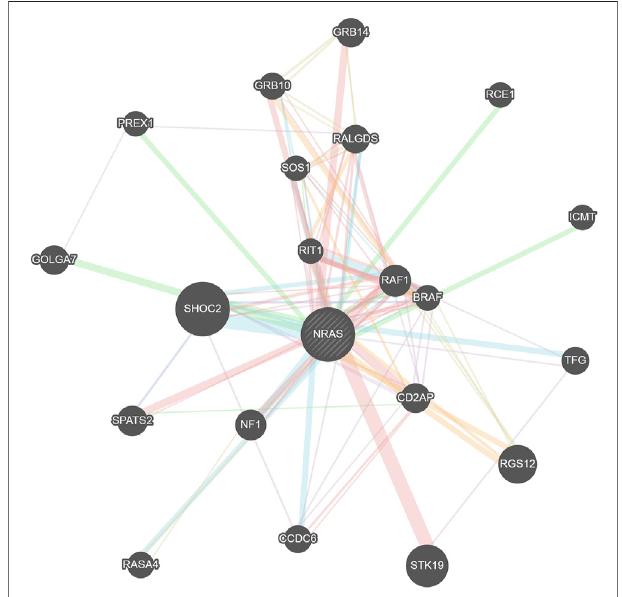
FIGURE 8 | Network of NRAS gene – gene interactions produced by the GeneMANIA